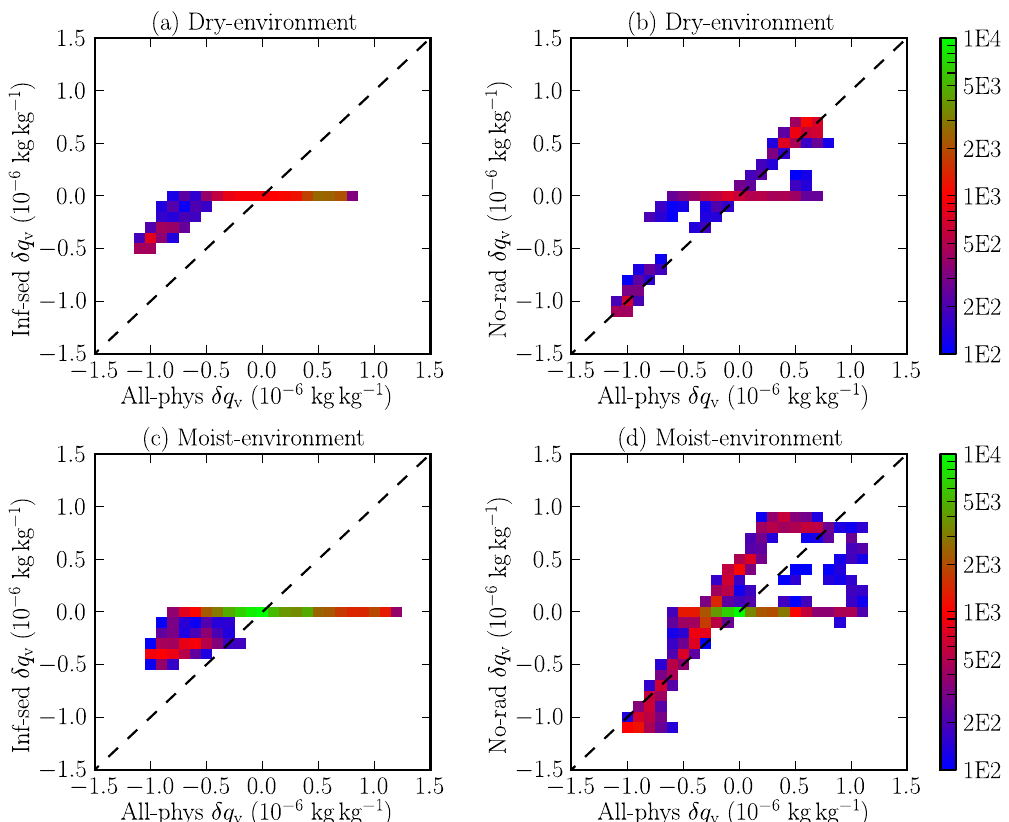
Figure 8. Changes in specific humidity of the cloudy air parcels in the inf-sed simulations versus the all-phys simulations (left column) and in the no-rad simulations versus the all-phys simulations (right column) for the dry (top row) and moist (bottom row) scenarios. The baseline water vapour distributions (abscissae in all four panels) are taken from the all-phys simulations. The dashed line shows the one-to-one slope. The colour bar shows the number of air parcel